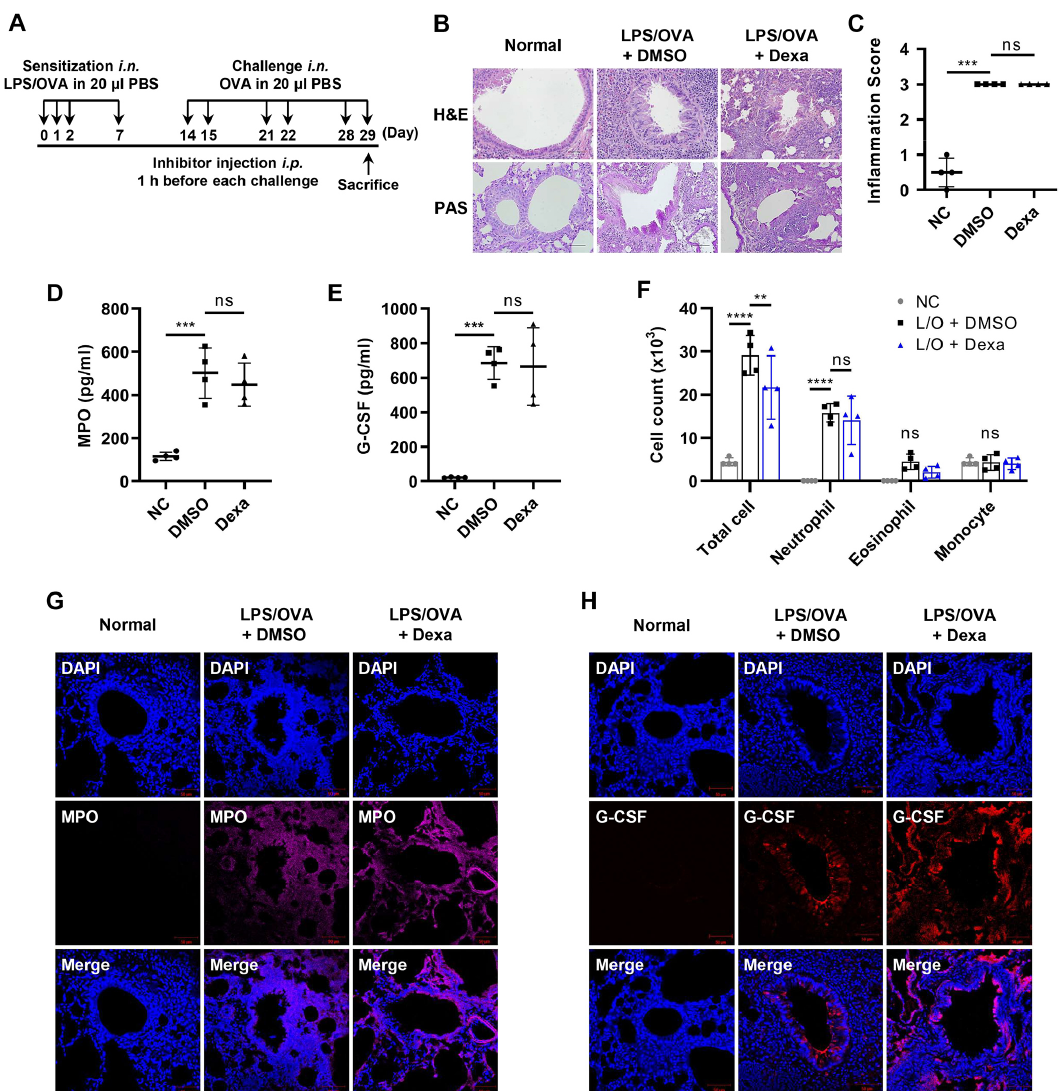
Figure 1. Elevated levels of G ‐ CSF in the steroid ‐ resistant neutrophilic lung airway inflammation model. For the experiment, mice were administered dexamethasone (Dexa; 1 mg/kg) or DMSO by i.p. injection 1 h before each challenge ( n = 4 per group). The negative controls (NC) were not treated. ( A ) Scheme of the LPS/OVA ‐ induced steroid ‐ resistant neutrophilic airway inflammation model. ( B , C ) H&E and PAS staining of mice lung tissues. Perivascular and peribronchial inflammation, in addition to mucus secretion, was examined and scored (400×). Inflammation scores are shown as the mean ± SD ( n = 4 per group). ( D , E ) MPO and G ‐ CSF levels in BALF were analyzed by ELISA. ( F ) The number of immune cells in BALF was estimated using a CytoSpin and staining with Diff ‐ Quik. The results are shown as the mean ± SD ( n = 4 per group). ( G , H ) Immunofluorescence (IF) staining of mice lung tissues for MPO (magenta, Alexa Flour 594) and G ‐ CSF (red, Alexa Flour 647). The nuclei were counterstained with DAPI (blue; 400×). The IF images are representatives of three independent trials with similar results. All experiments were performed in triplicate. ** p < 0.01, *** p < 0.001, **** p < 0.0001, ns: not significant versus each control group.